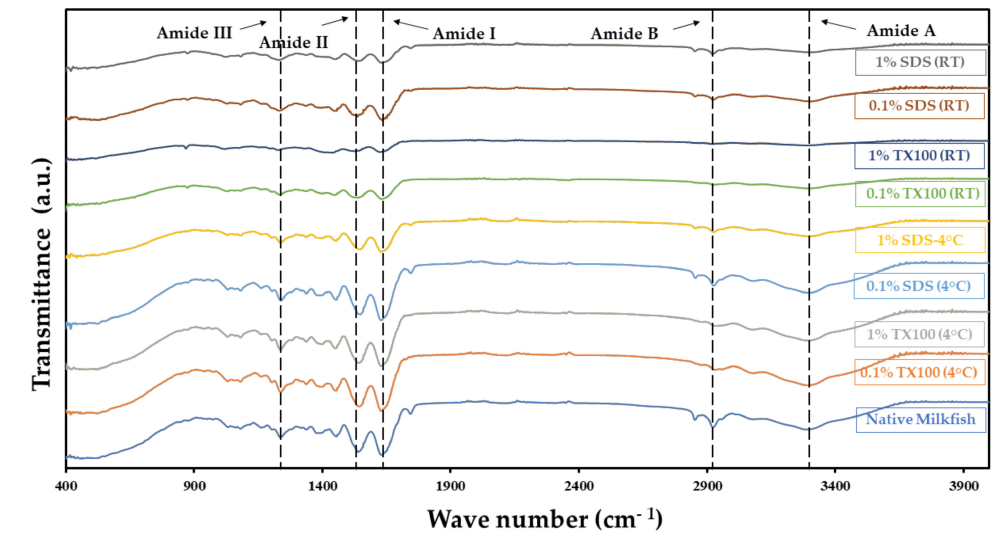
Figure 3. ATR-FTIR spectra of the native and decellularized milkfish skin show that amide bands were preserved after